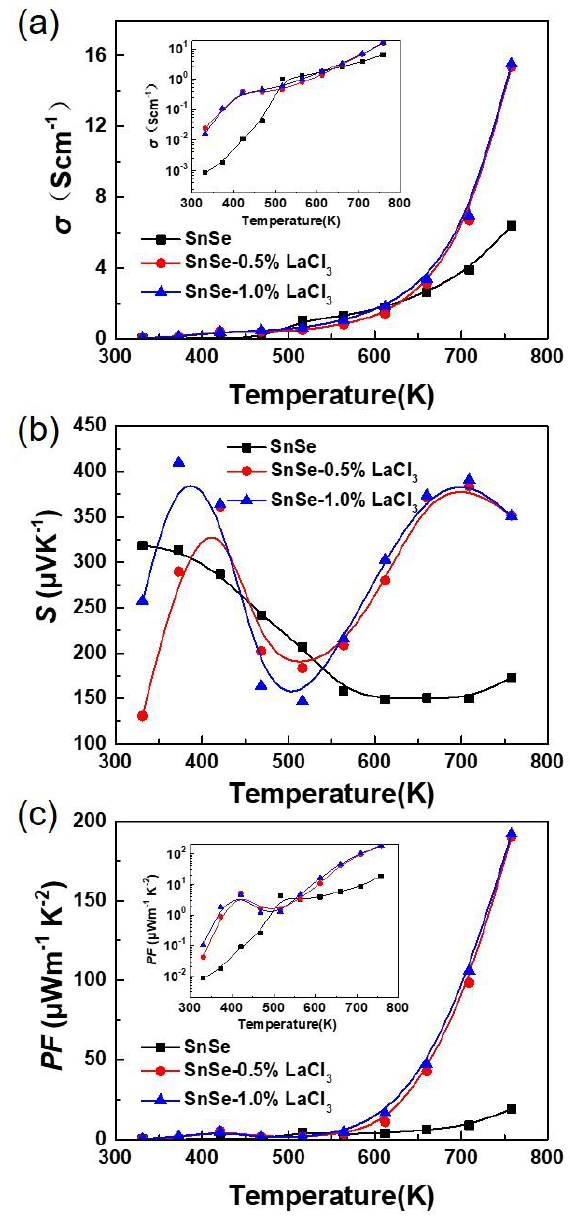
Figure 3. Electrical transport properties as a function of temperature for all the samples SnSe- x wt % LaCl 3 ( x = 0.0, 0.5, and 1.0). ( a ) electrical conductivity; ( b ) Seebeck coefficient; ( c ) power factor.